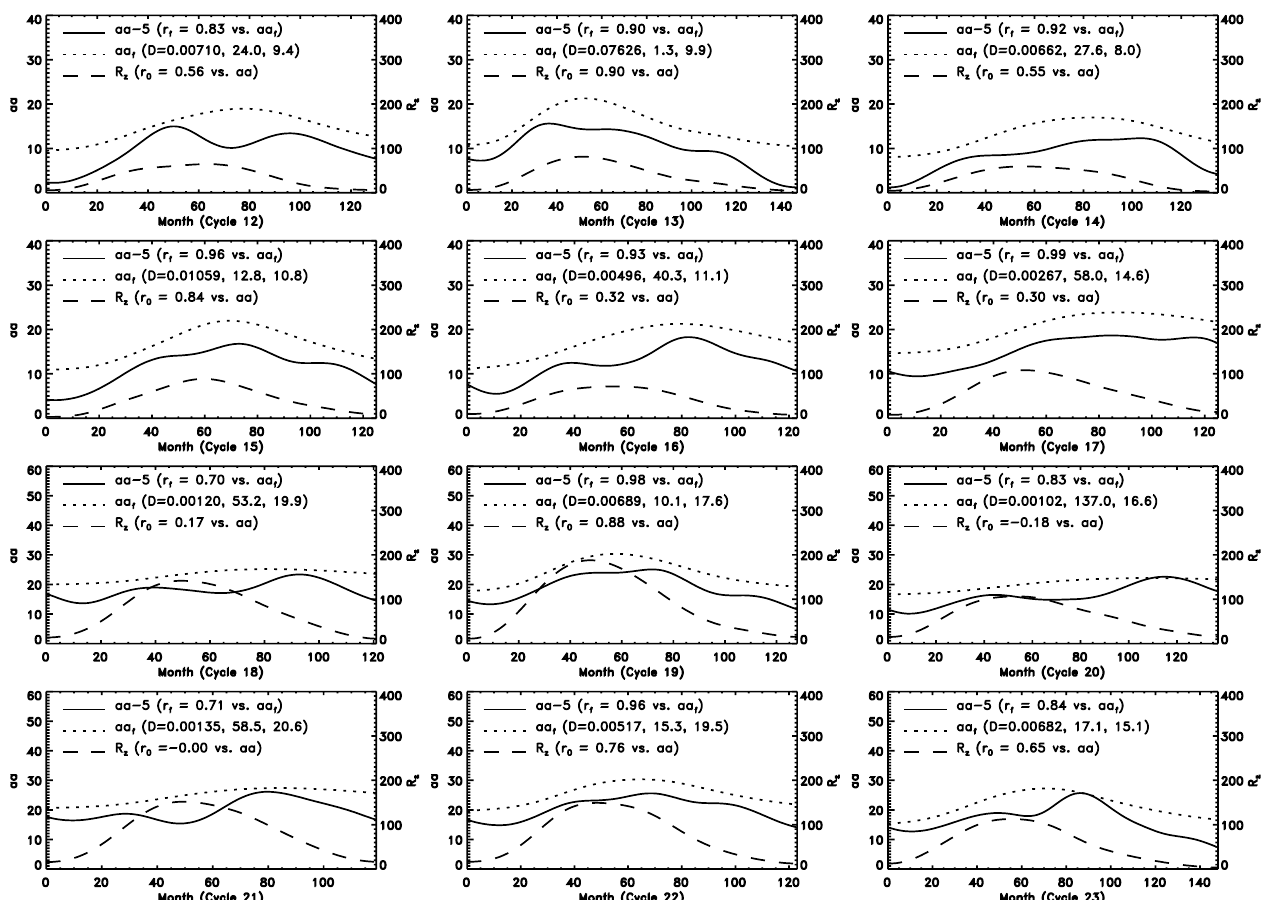
Fig. 10. Monthly mean aa − 5 (solid, shifted downward by 5 for clarity) and R z (dashed) smoothed with a 24-month Gaussian filter, and the reconstructed aa series ( aa f , dotted) by Model (10) for each cycle of n = 12 to 23. In each plot are also shown the correlation coefficient of aa with R z ( r 0 ), that of aa with aa f ( r f ), and the three parameters of D , τ and aa 0